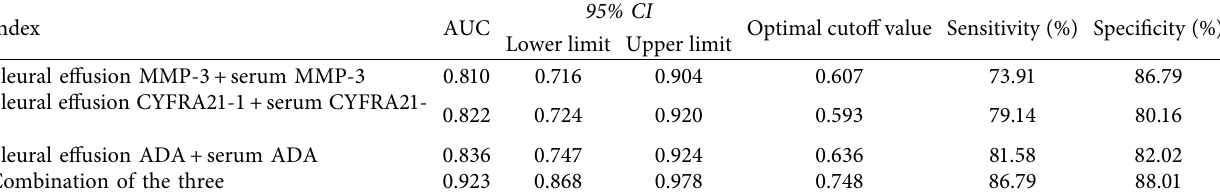
Table 3: Differential diagnostic value of combined hydrothorax and serum MMP-3, CYFRA21-1 and ADA in PEE.